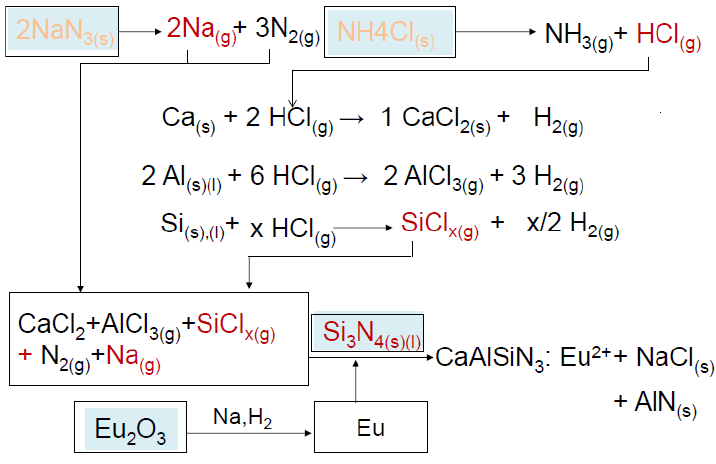
Figure 6. The proposed reaction